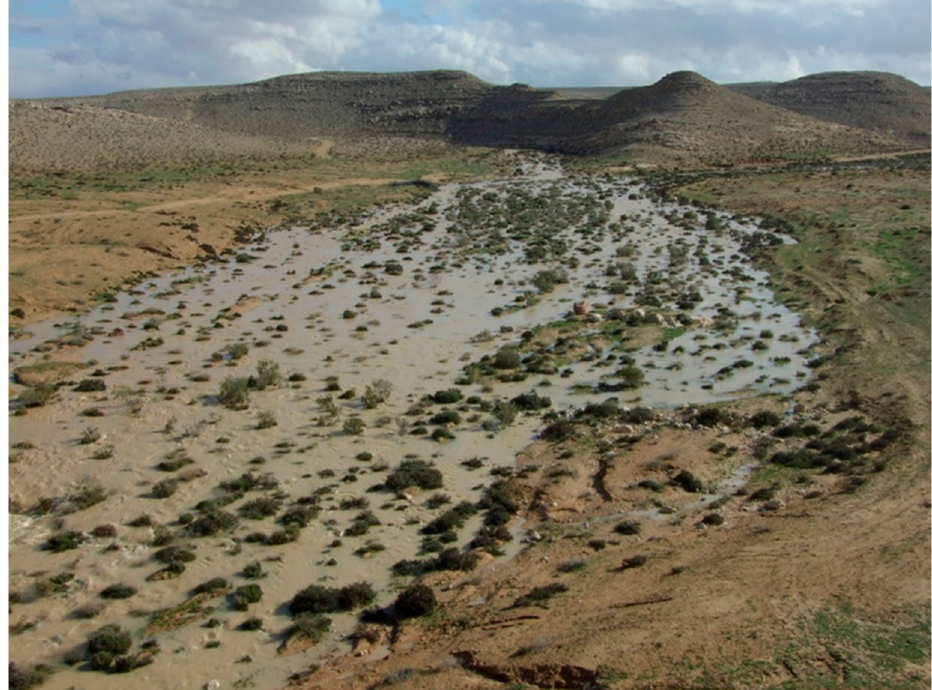
Figure 3. Negev Highlands, Southern Israel. Note the hilly topography at the background, composed of Eocene marine carbonates (limestone and chalk). Late Pleistocene loess sediments were deposited in the valley. Floodwater resulting from winter rain is the main irrigation source for local vegetation. (Photograph: Y. Avni).